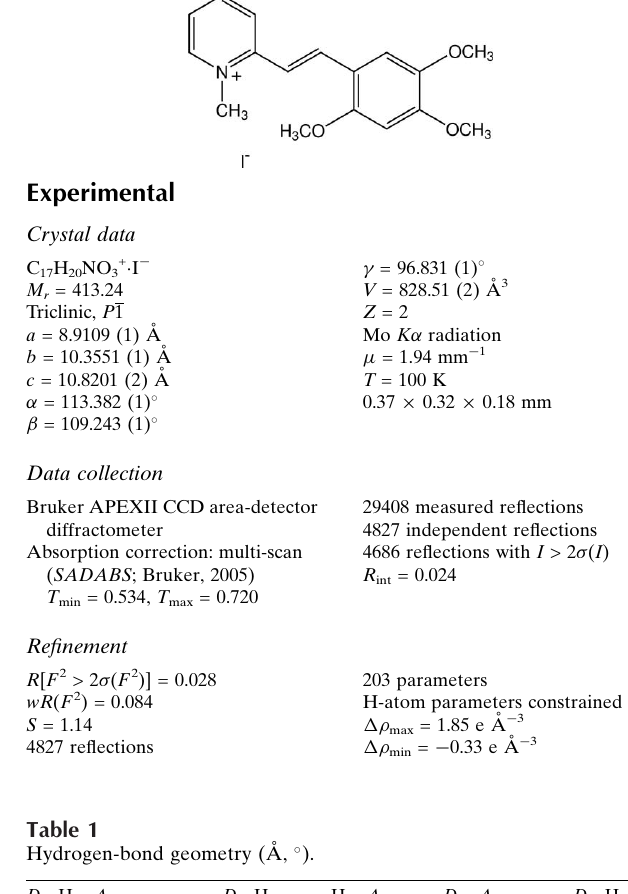
Hydrogen-bond geometry (A˚ , (cid:4)